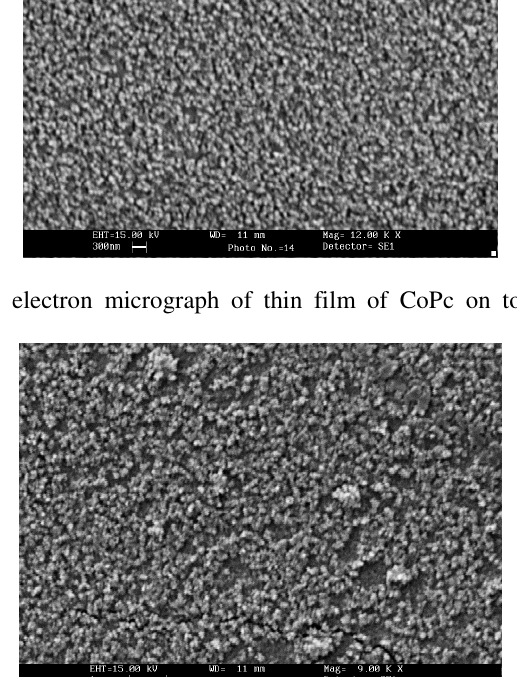
Figure 4 . Scanning electron micrograph of CoPc thin film of on to the glass substrate deposited at